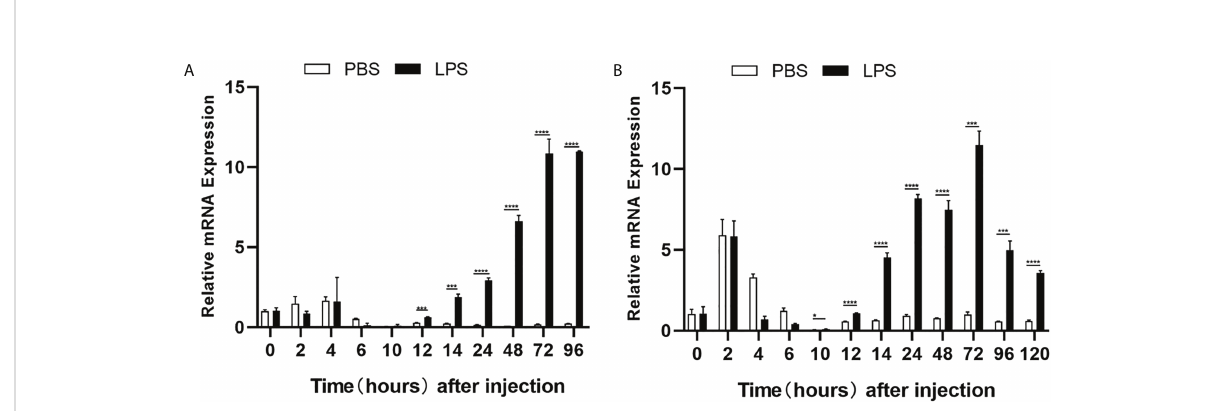
FIGURE 6 Quantitative analysis of zebra fi sh cd248a and cd248b genes in response to LPS/PBS treatment. (A) Quantitative analysis of zebra fi sh cd248a in infected embryos/larvae by microinjecting LPS at 1-cell stage; (B) Quantitative analysis of zebra fi sh cd248b in infected embryos/larvae by microinjecting LPS at 1-cell stage. PBS, Phosphate Buffered Saline; LPS, lipopolysaccharide. Data were shown as mean ± SD, n = 3. * P < 0.05; *** P < 0.001; **** P <